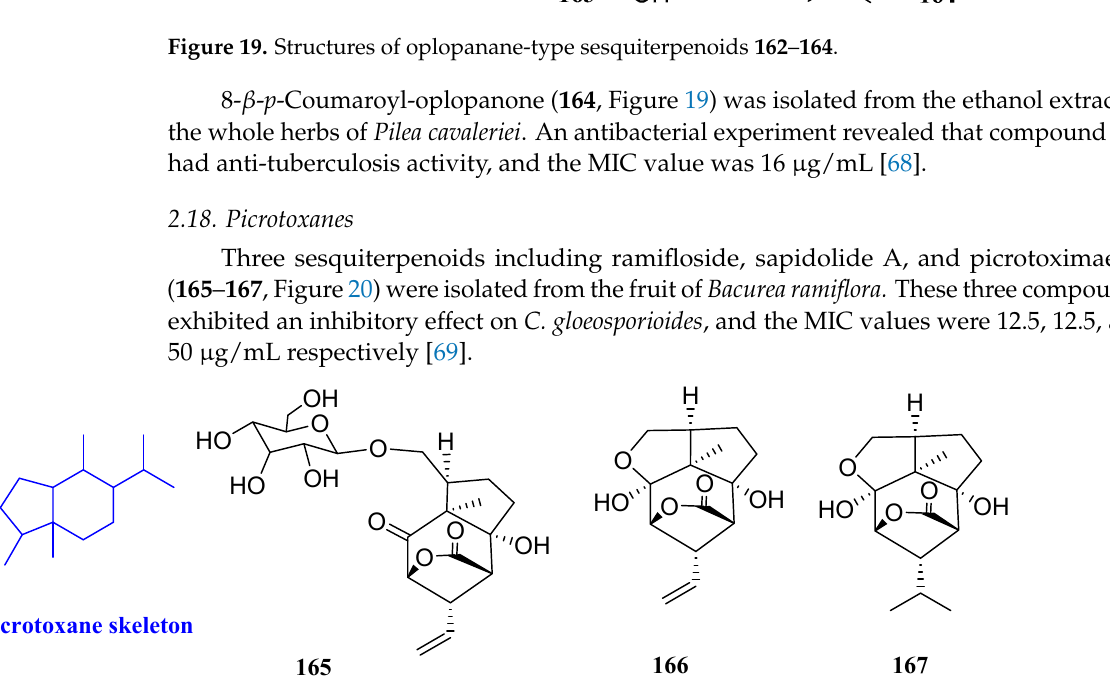
Figure 21. Structures of rhodolaurane - type sesquiterpenoids 168 – 170 .